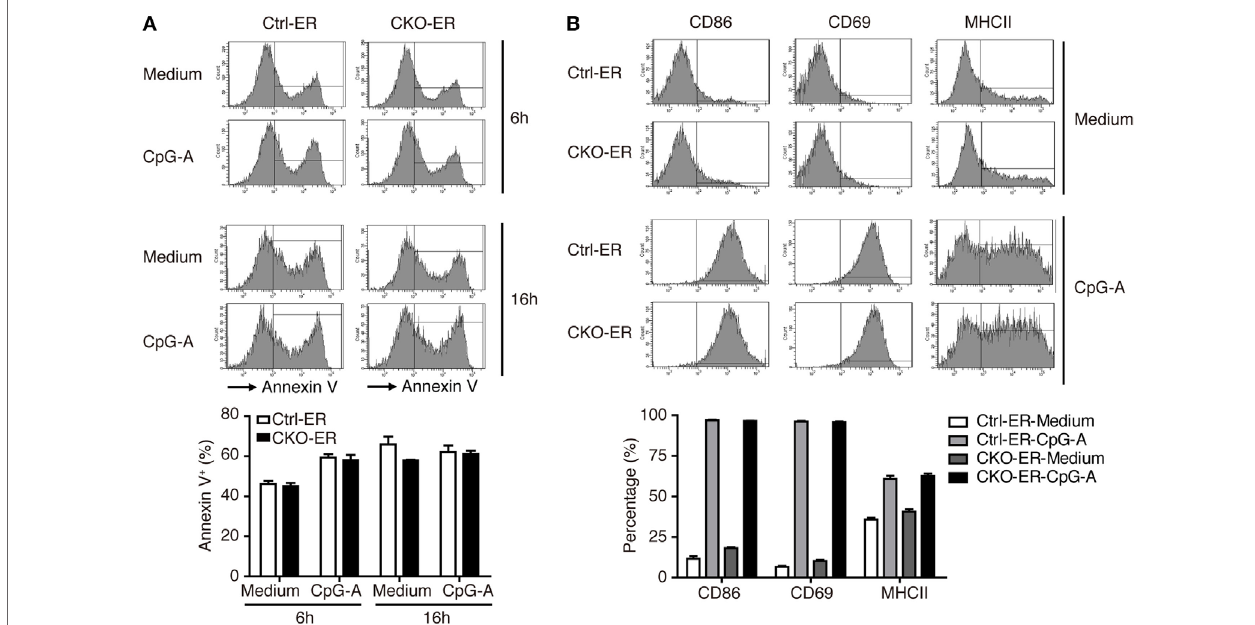
FigUre 5 | Activation and apoptosis were not affected in Blimp-1-deficient FLpDCs. (a) Flow cytometric analysis showing the frequency of Annexin V positive cells in 4-OHT treated Ctrl-ER or CKO-ER FLpDCs stimulated with 1 µM CpG-A or medium alone for 6 and 16 h. (B) Flow cytometric analysis of CD86, CD69, and MHCII expression on 4-OHT treated Ctrl-ER or CKO-ER FLpDCs with or without 16 h of 1 µM CpG-A stimulation. The positive frequency of each marker is indicated. Results represent the mean ± SEM and were analyzed by two-tailed unpaired Student’s t -test [ n = 3 in (a,B)